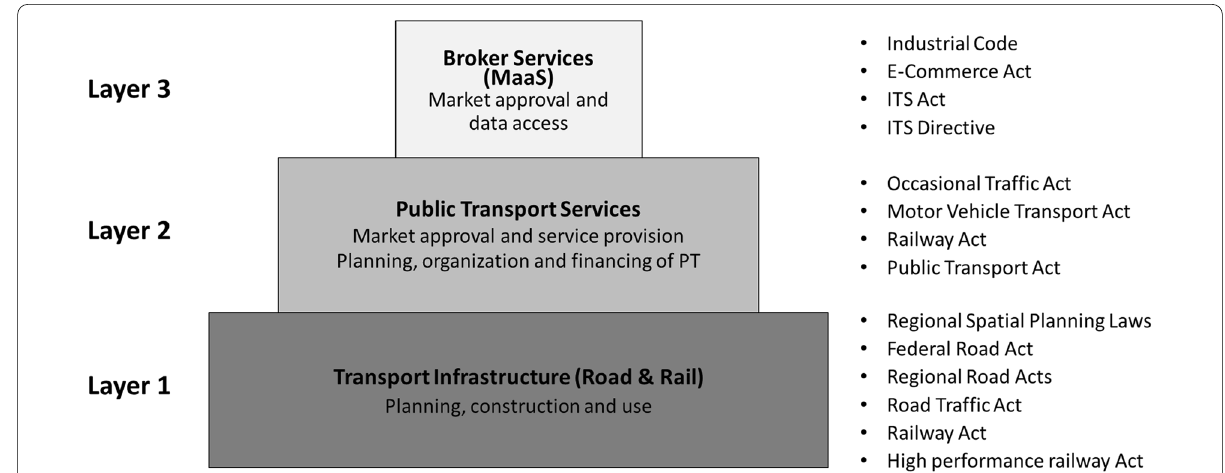
Fig. 2 Three legal layers in the Austrian transport sector and corresponding laws and